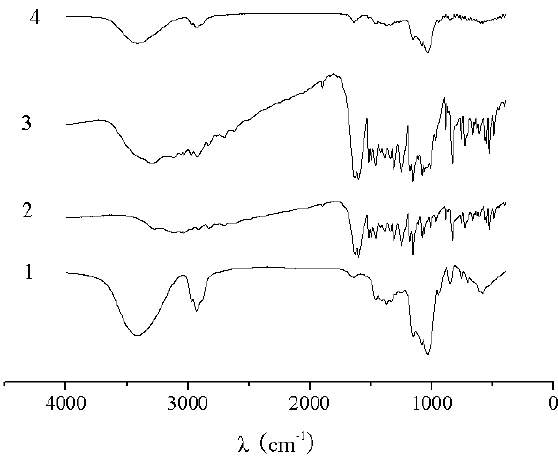
Figure 3. IR spectra of HP- β -CD ( 1 ), naringenin ( 2 ), physical mixture of naringenin and HP- β -CD ( 3 ) and complex of naringenin and HP- β -CD ( 4